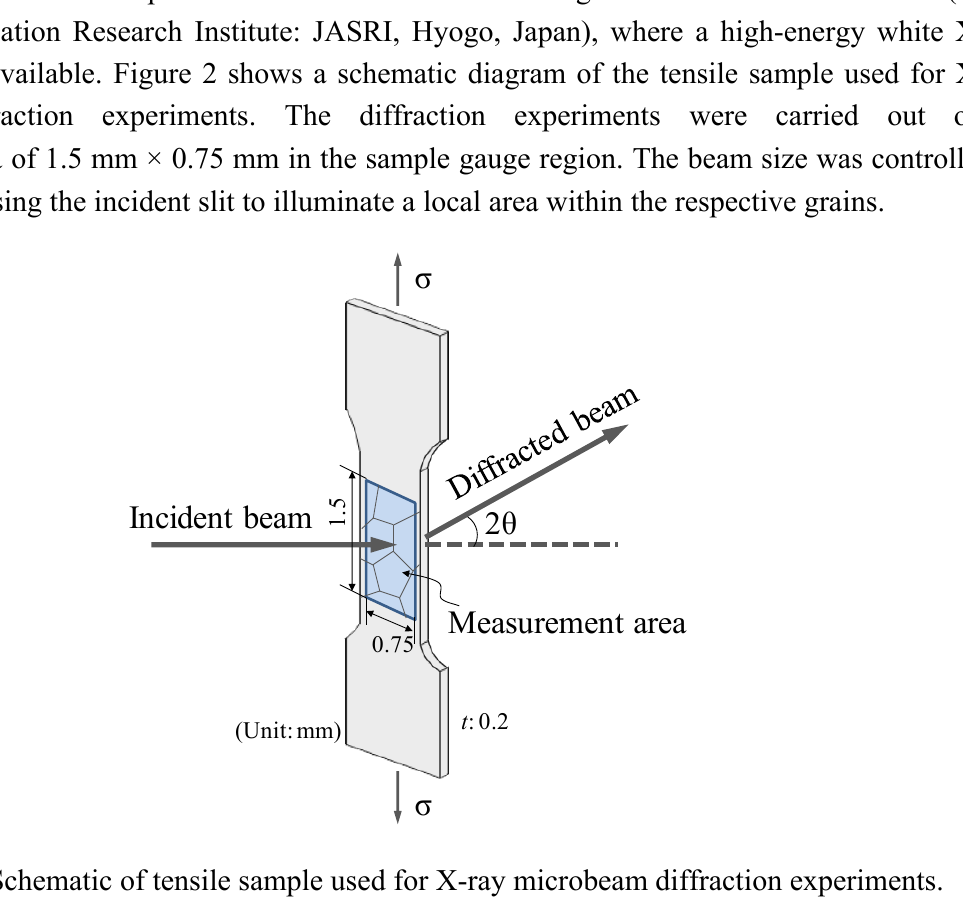
Figure 2. Schematic of tensile sample used for X-ray microbeam diffraction